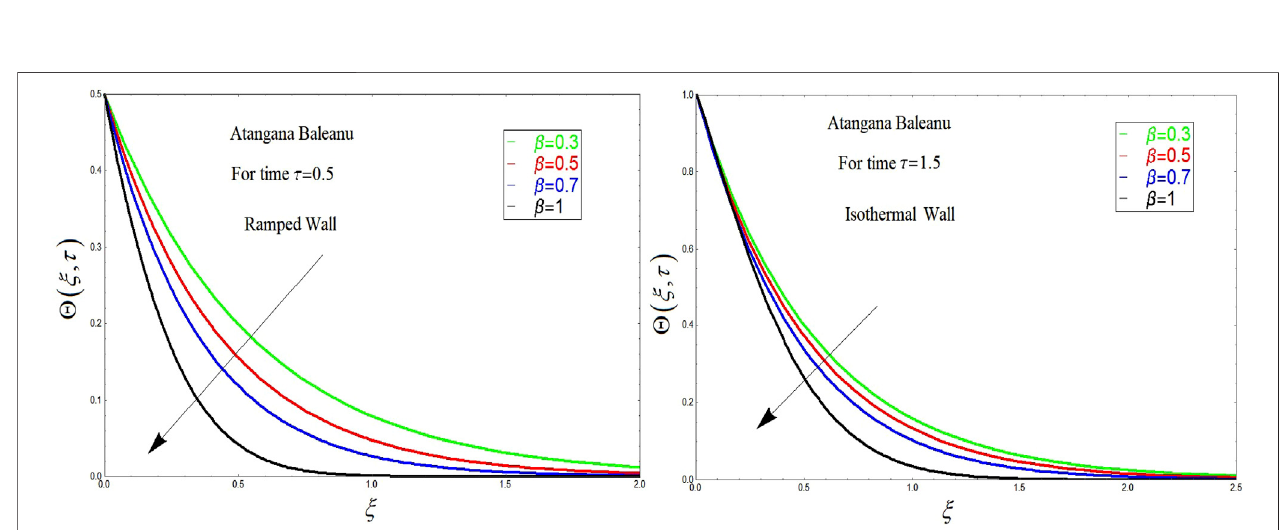
FIGURE 7 | In fl uence of λ 1 on velocity for constant and ramped temperature.